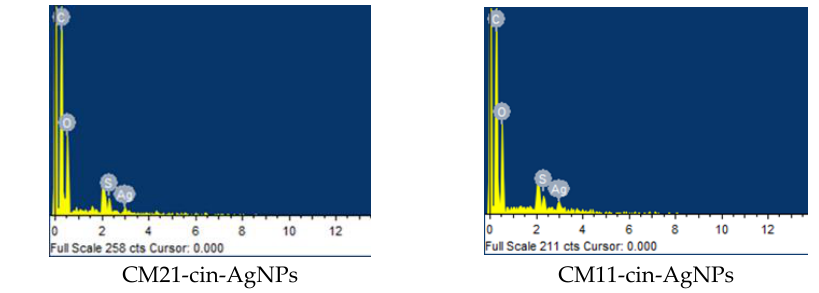
Figure 4. The EDS results of various AgNPs containing cinnamaldehyde-modified mercaptosuccinic acid-crosslinked chitosan hydrogels.